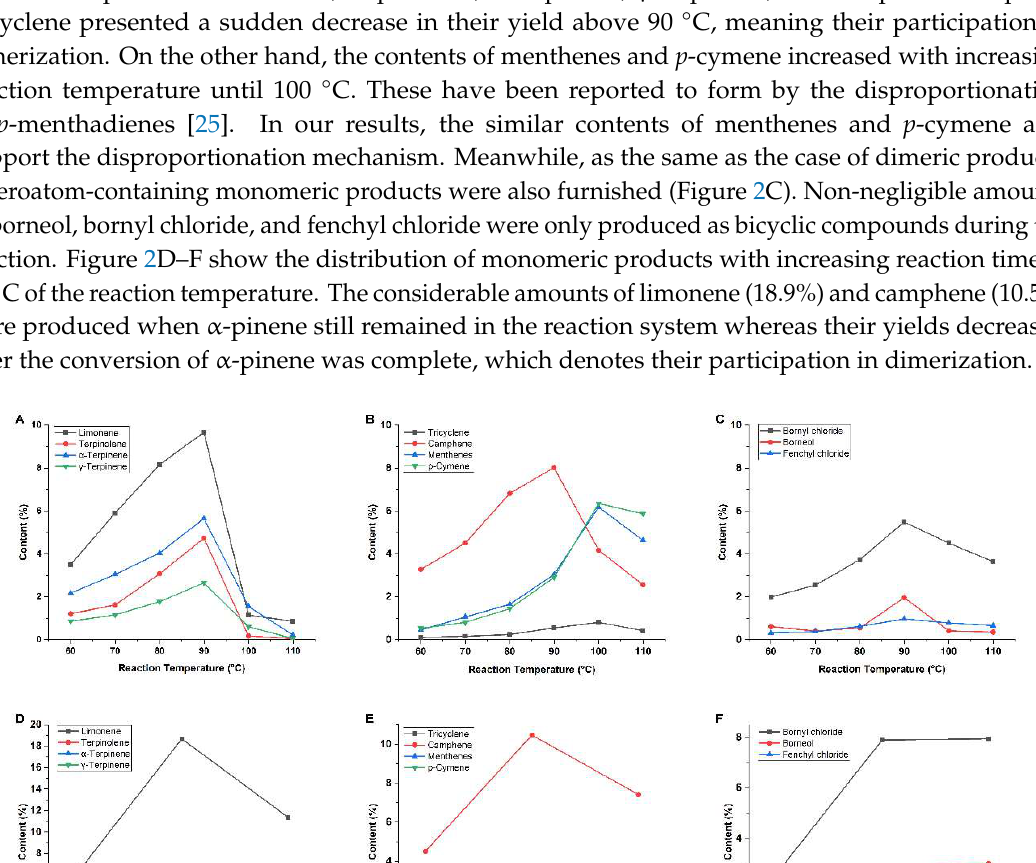
Figure 1. E ff ect of reaction temperature and reaction time on the conversion of α -pinene and yields of dimeric and trimeric products. The reaction was carried out ( A ) for 1 h and ( B ) at 70 ◦ C.